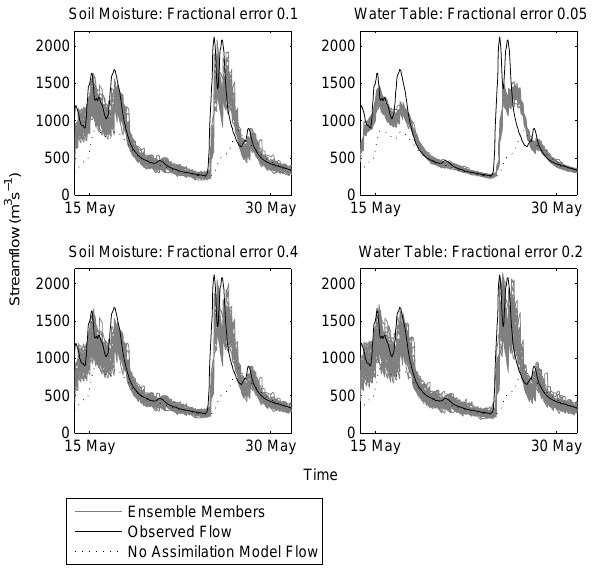
Table: Fractional error 0.2